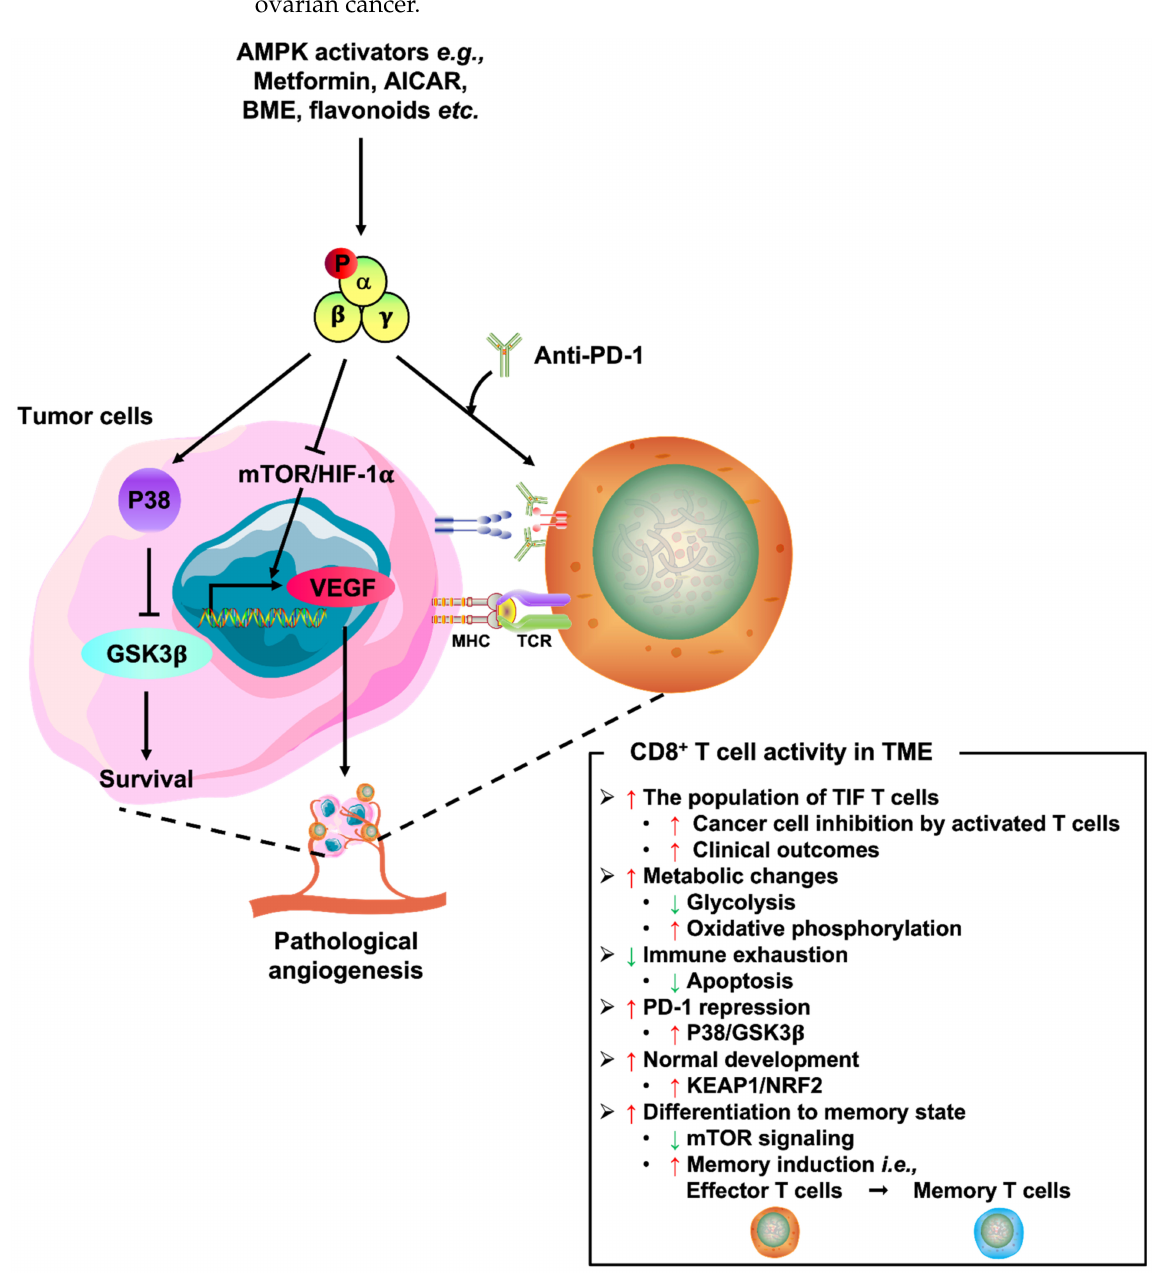
Figure 2. Several beneficial effects of AMPK activators on antitumor immunity. AMPK activation not only inhibits cell growth and survival in cancer cells per se, but it also stimulates TILs CD8 + T cell activity within the tumor microenvironment (TME) by enhancing the CD8 + T cell residents, preventing their immune exhaustion, maintaining their consistent activity via activating oxidative metabolism and facilitating their transition into the memory